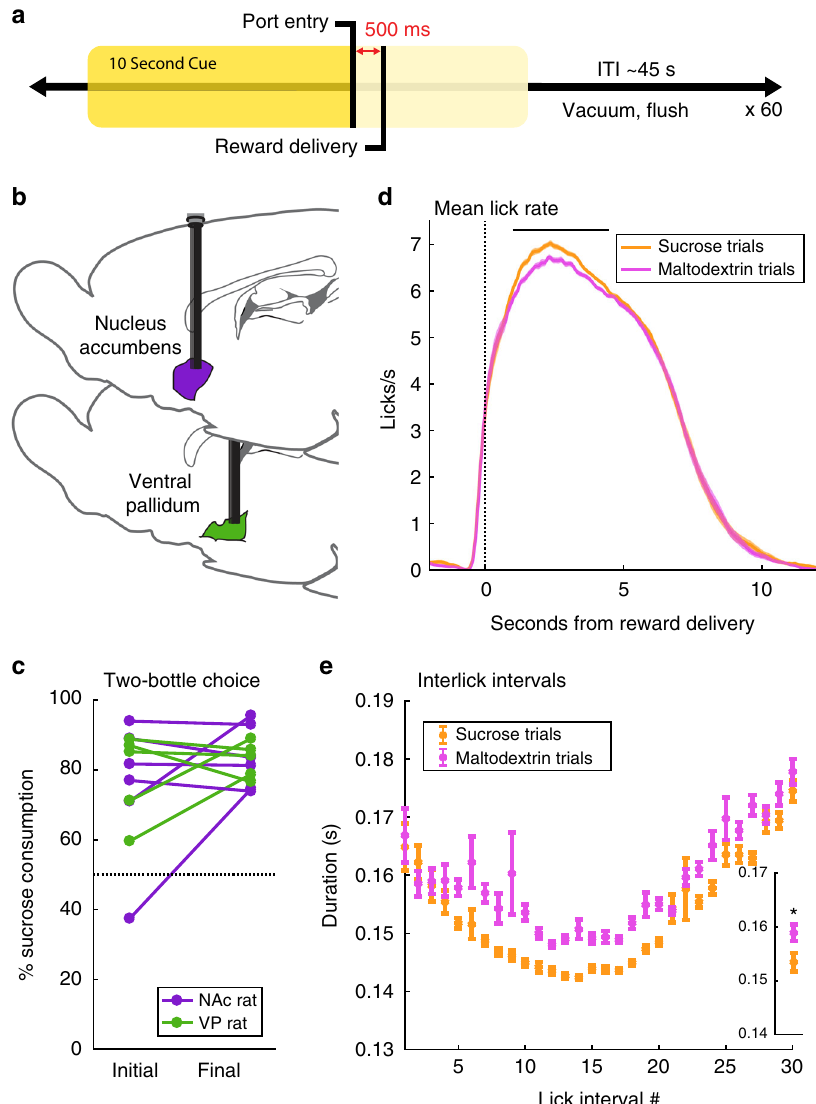
Fig. 1 Preference for sucrose over maltodextrin in home cage drinking and following cued reward delivery. a Task design. Sucrose or maltodextrin solution was delivered 500 ms following rats ’ entry into the reward port during a 10 s white noise cue. Trials of each reward were randomly interspersed throughout the session such that reward identity was unpredictable to the rat. b After training, drivable 16 electrode arrays were implanted in either nucleus accumbens ( n = 6) or ventral pallidum ( n = 5). See Supplementary Fig. 1 for placements. c Rats ’ preference (percentage sucrose consumption of